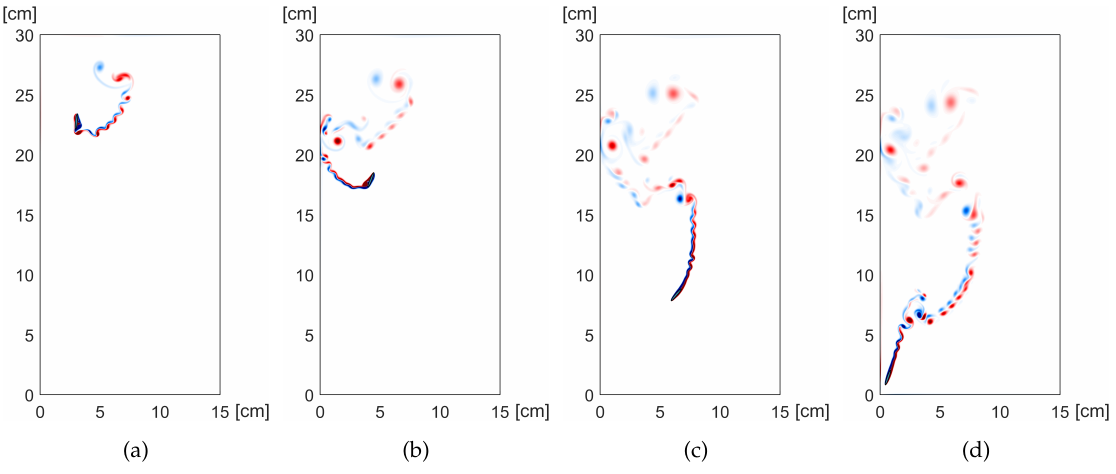
Figure 10. Wake structure in vorticity contours at time ( a ) t = 0.4 s, ( b ) t = 0.8 s, ( c ) t = 1.2 s, and ( d ) t = 1.5 s. This corresponds to the chaotic falling mode in Figure 8b.